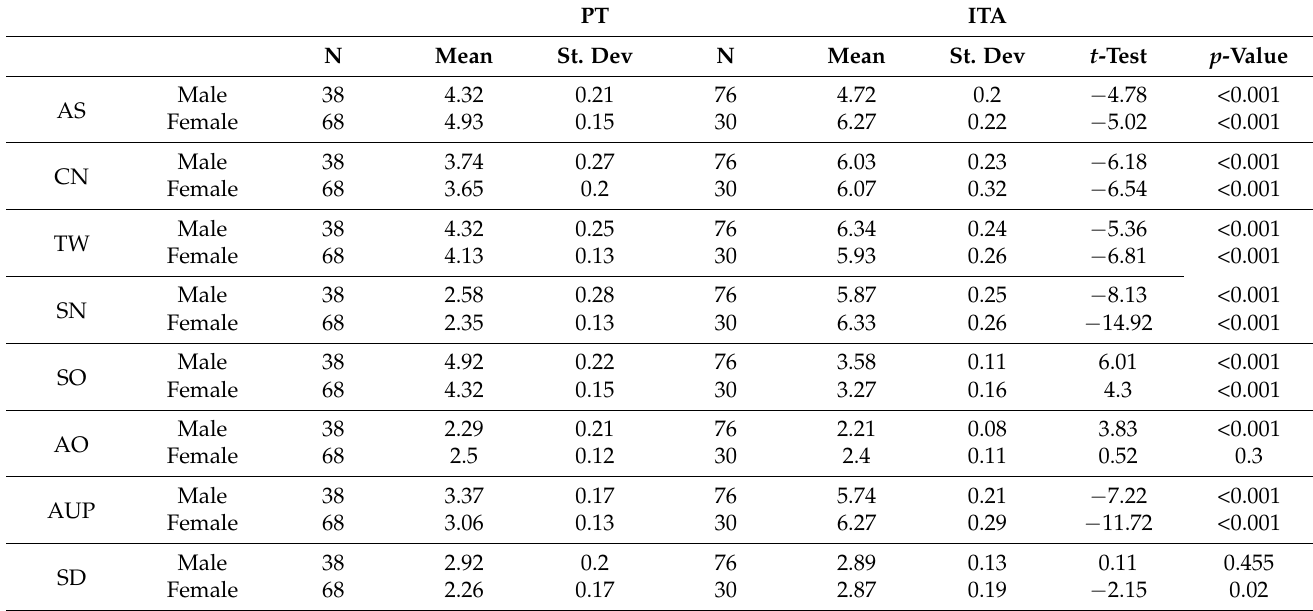
Table 5. Self-assessment of competences according to